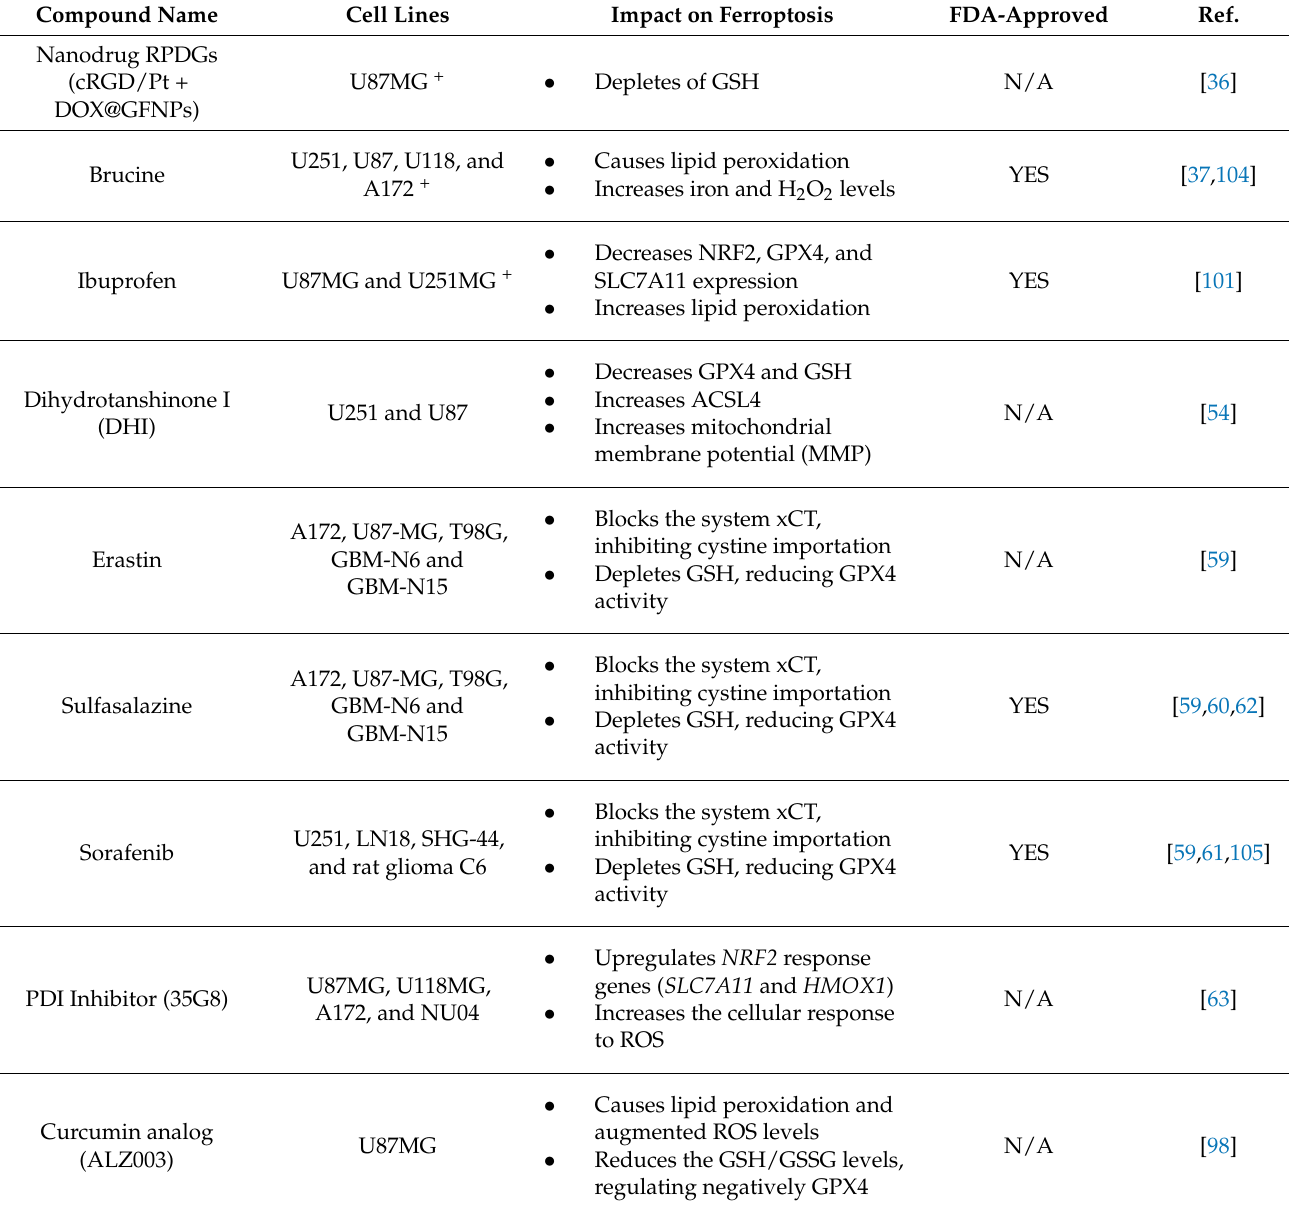
Table 1. The ferroptosis-inducing compounds in